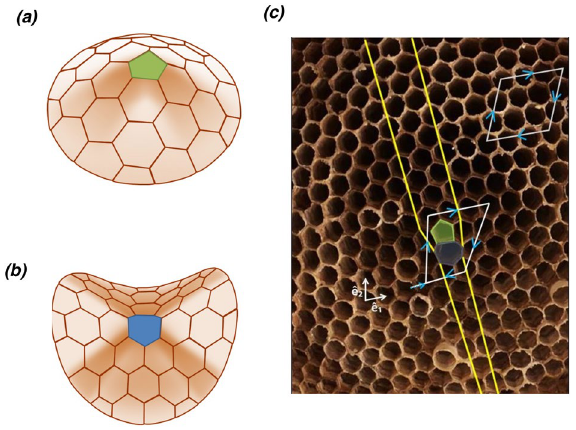
Figure 5. Illustration of emergent structure that deviates from planarity with the insertion of ( a ) a pentagon or ( b ) a heptagon (shading as a guide to the eye). ( c ) A disclination pair is indicated on a wasp nest. A view of parallel lines encompassing an additional hexagonal layer as they pass through this pair, thereby leaving a scar on the lattice (dislocation line). A Burgers vector obtained from a loop enclosing the dislocation is a topological invariant. A loop not enclosing a defect is shown on the top right.